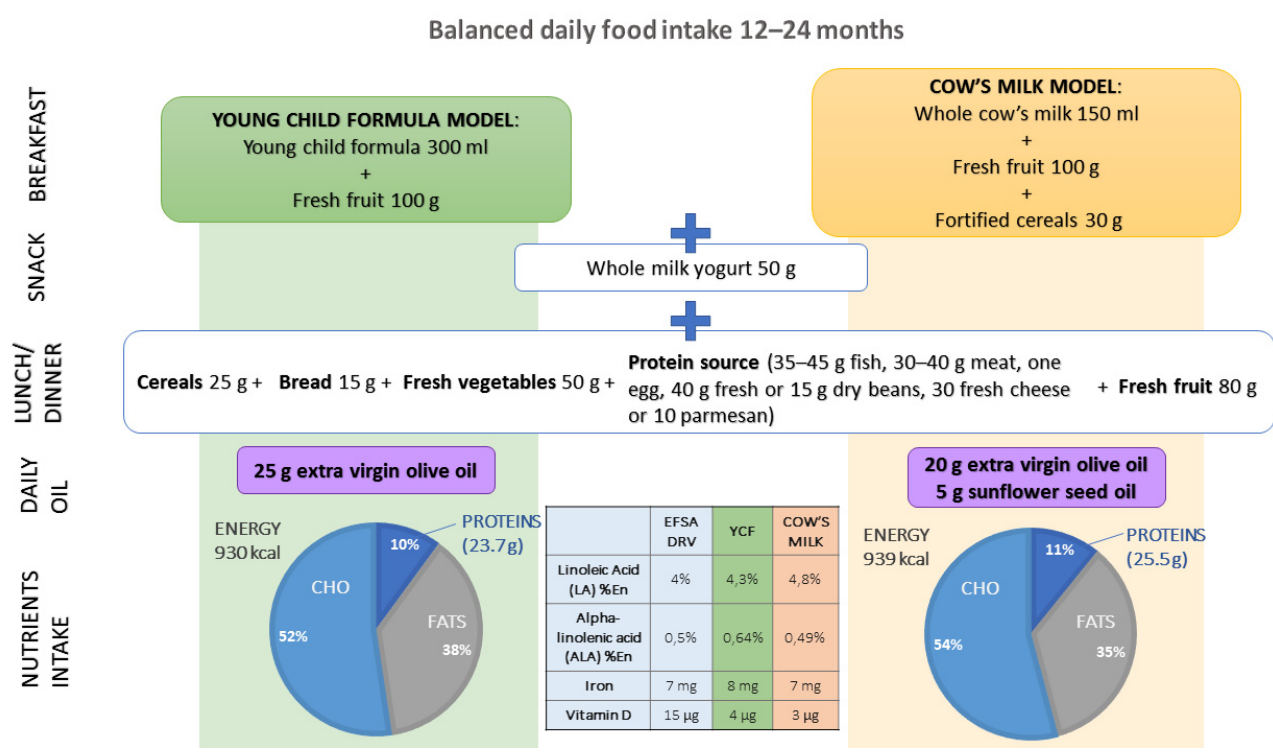
Figure 1. Suggested daily food intake for 12–24-month-old children depending on the type of milk consumed (young child formula, cow’s milk) to ensure a nutrients intake within the range of reference values.